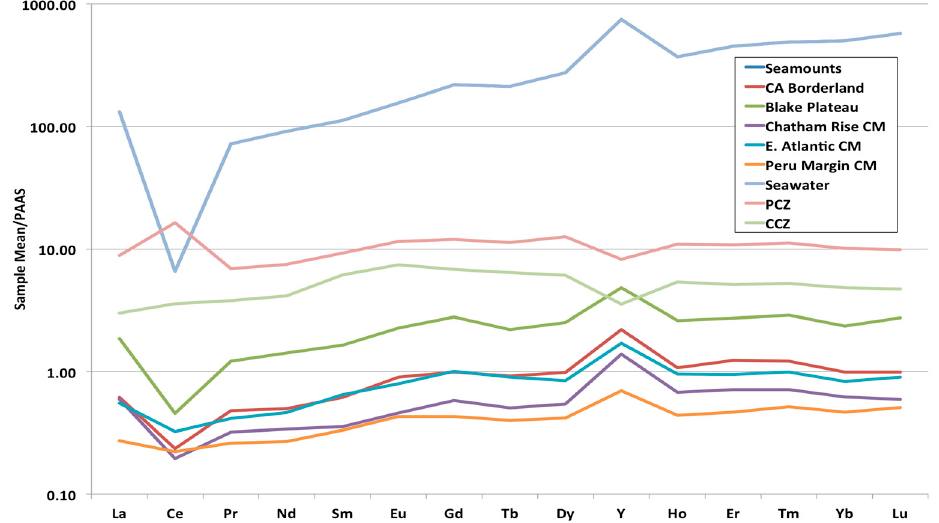
Figure 5. Post Archean Australian Shale-normalized rare earth element plot for mean data of sample groups compared with patterns for Prime Crust Zone (PCZ) crusts, Clarion-Clipperton Zone (CCZ) nodules, and seawater (× 10 9 ) at ~2000 m water depth [19].